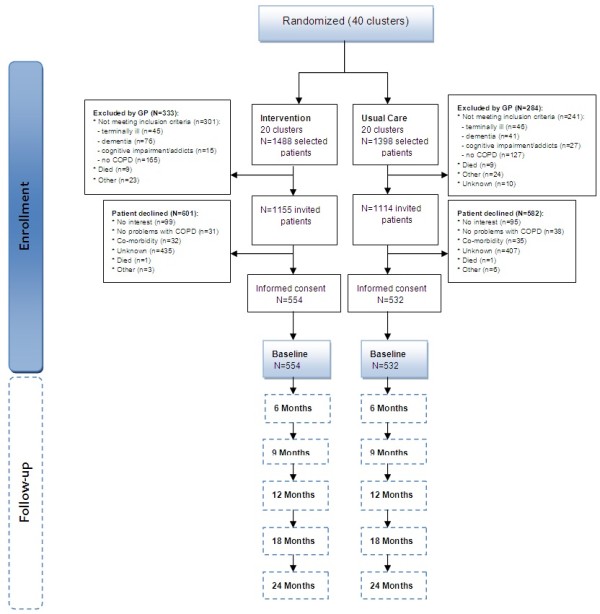
Flowchart of the recruitment to the baseline assessment of the RECODE study.